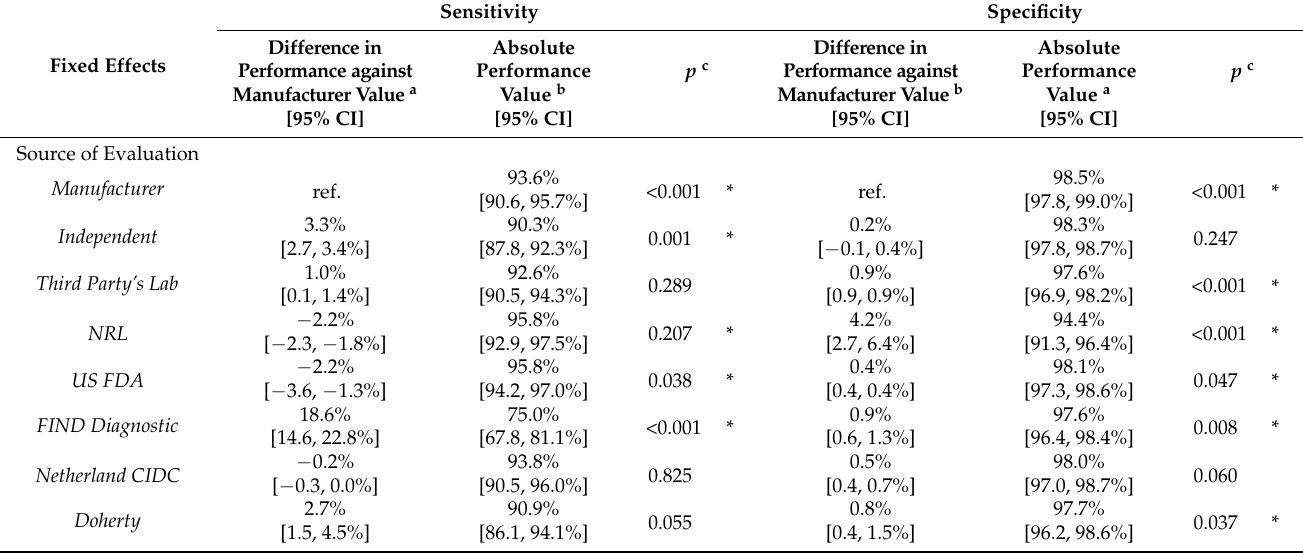
Table 2. Predictors of assay Sn. and Sp. estimated with mixed-effect beta regression (N = 192).